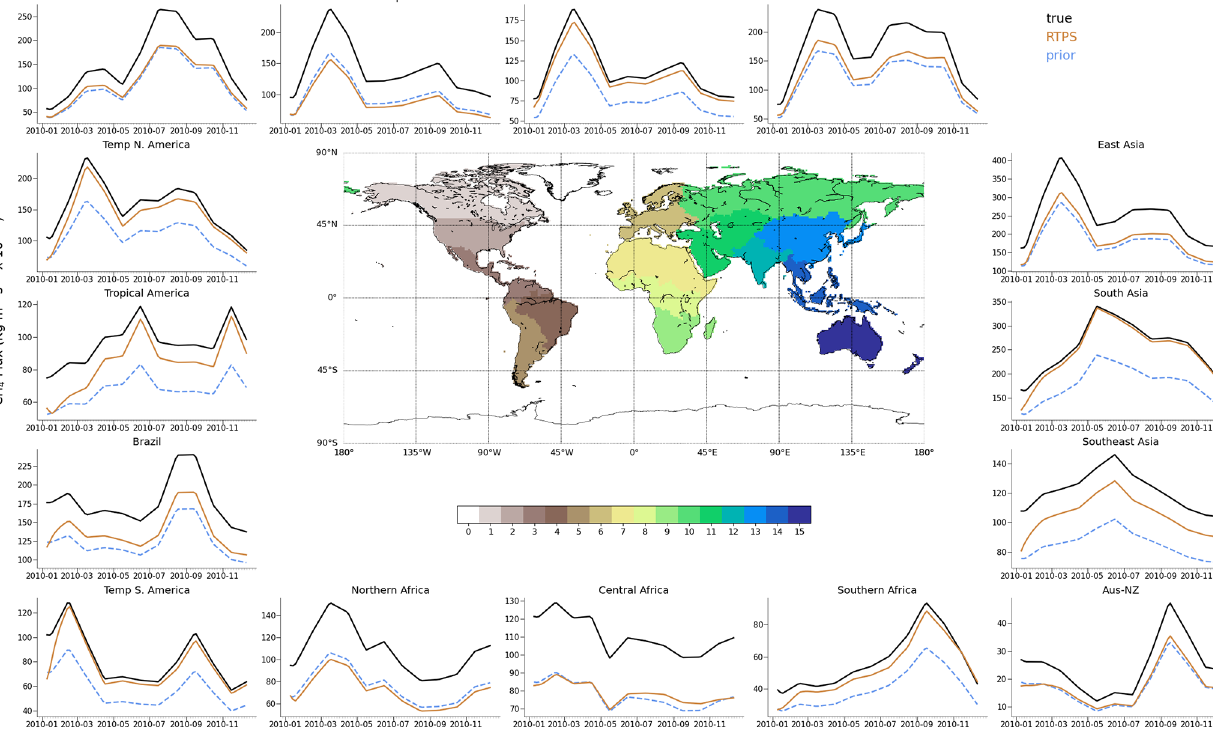
Figure 8. Same as Fig. 3 but after assimilating synthetic GOSAT